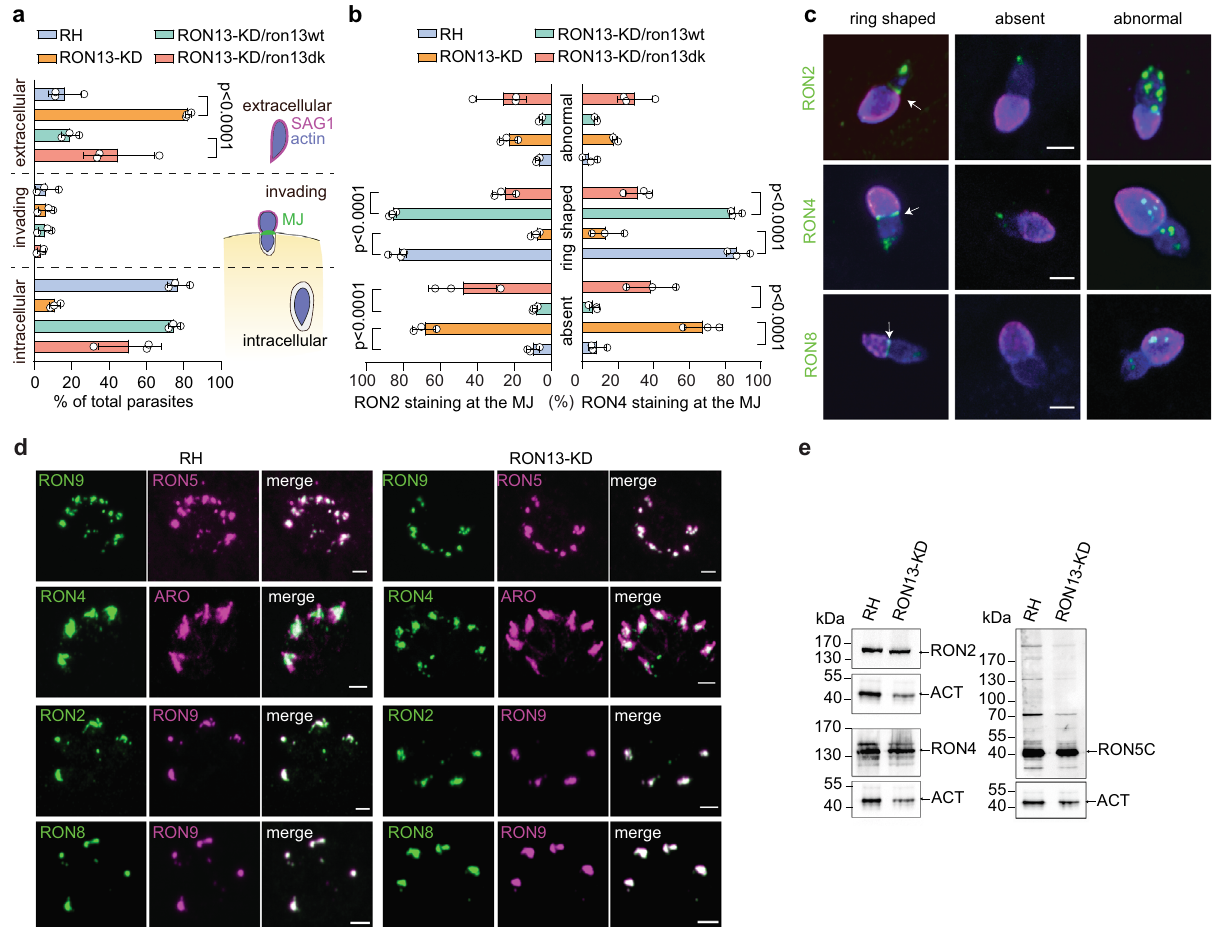
Fig. 8 RON13 kinase activity is important for moving junction formation during invasion. a Graph representing the proportion of extracellular, invading, and intracellular parasites observed in the pulse-invasion assay. The scheme depicts the three stages of the invasion process considered in this assay (mean ± SD; n = 3 biologically independent experiments). Statistical signi fi cance was assessed by a one-way ANOVA signi fi cance with Tukey ’ s multiple comparison. b Quanti fi cation of the different types of RON2 and RON4 staining (absent, abnormal, and ring shaped) observed at the MJ of invading parasites. (Mean ± SD; n = 3 biologically independent experiments). Statistical signi fi cance was assessed by a one-way ANOVA signi fi cance with Tukey ’ s multiple comparison. c IFAs showing a representative example of RON2, RON4 and RON8 staining (green) of invading RON13-KD parasites obtained from three biologically independent experiments. An arrow indicates the bona fi de ring-shaped MJ. Anti-SAG1 (magenta) and anti-actin (blue) antibodies stain the extracellular part of the parasite and the parasite cytoplasm, respectively. For the last row, anti-GAP45 antibodies (blue) were used. Scale bar = 2 µ m. d IFAs on RH and RON13-KD intracellular parasites showing that proteins of the RON complex are well expressed and addressed to the rhoptry in RON13- KD-treated parasites. For the fi rst row, RON5 is in magenta and RON9 in green. RON4, RON2, and RON8 are in green. Anti-ARO (magenta) and anti- RON9 (magenta) antibodies are used as rhoptry compartment markers. Scale bar = 2 µ m. Image representative of three biologically independent experiments. e WB showing a comparable level of expression of RON complex proteins between RH and RON13-KD parasites using anti-RON2, anti-RON4, and anti-RON5C antibodies. Actin (anti-ACT) is used as a loading control. Image representative of three biologically independent experiments. Source data are provided as a Source data fi